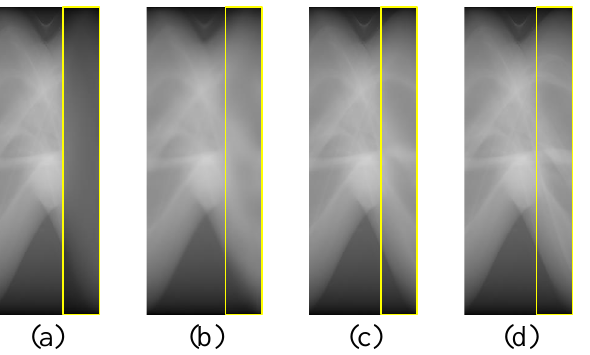
Figure 8. Visualized restoration results obtained from different data preprocessing methods, ( a ) is the input; ( b ) is the restoration result of structure (1); ( c ) is the restoration result of structure (2); ( d ) is the ground truth.